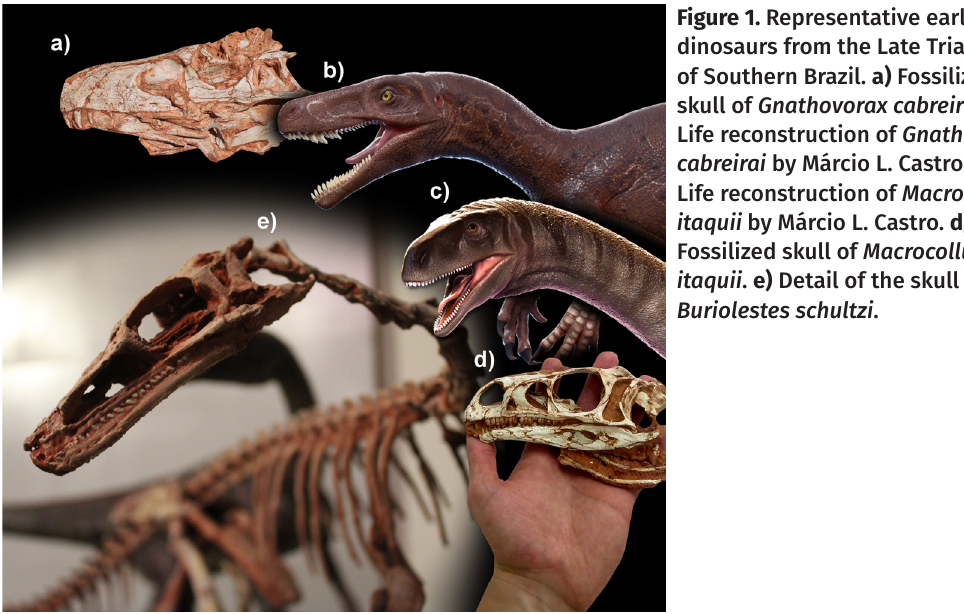
Figure 1. Representative early dinosaurs from the Late Triassic of Southern Brazil. a) Fossilized skull of Gnathovorax cabreirai . b) Life reconstruction of Gnathovorax cabreirai by Márcio L. Castro. c) Life reconstruction of Macrocollum itaquii by Márcio L. Castro. d) Fossilized skull of Macrocollum itaquii . e) Detail of the skull cast of Buriolestes schultzi